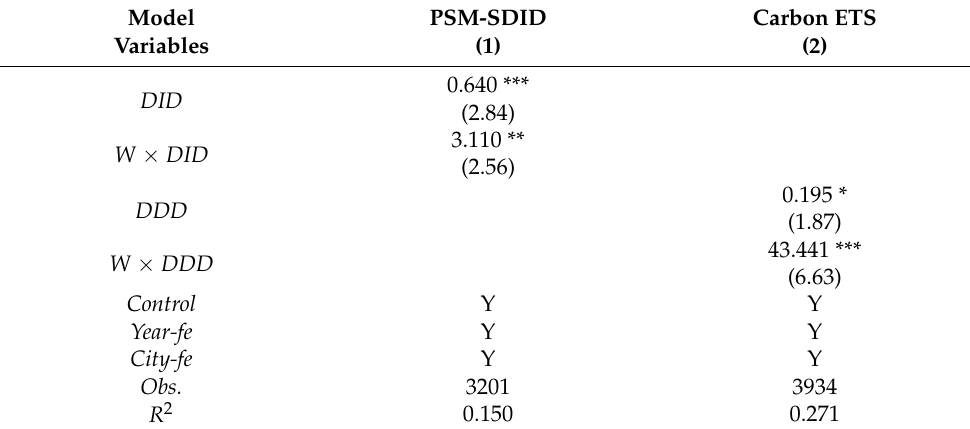
Table 4. Estimation results in PSM-SDID and effect with Carbon